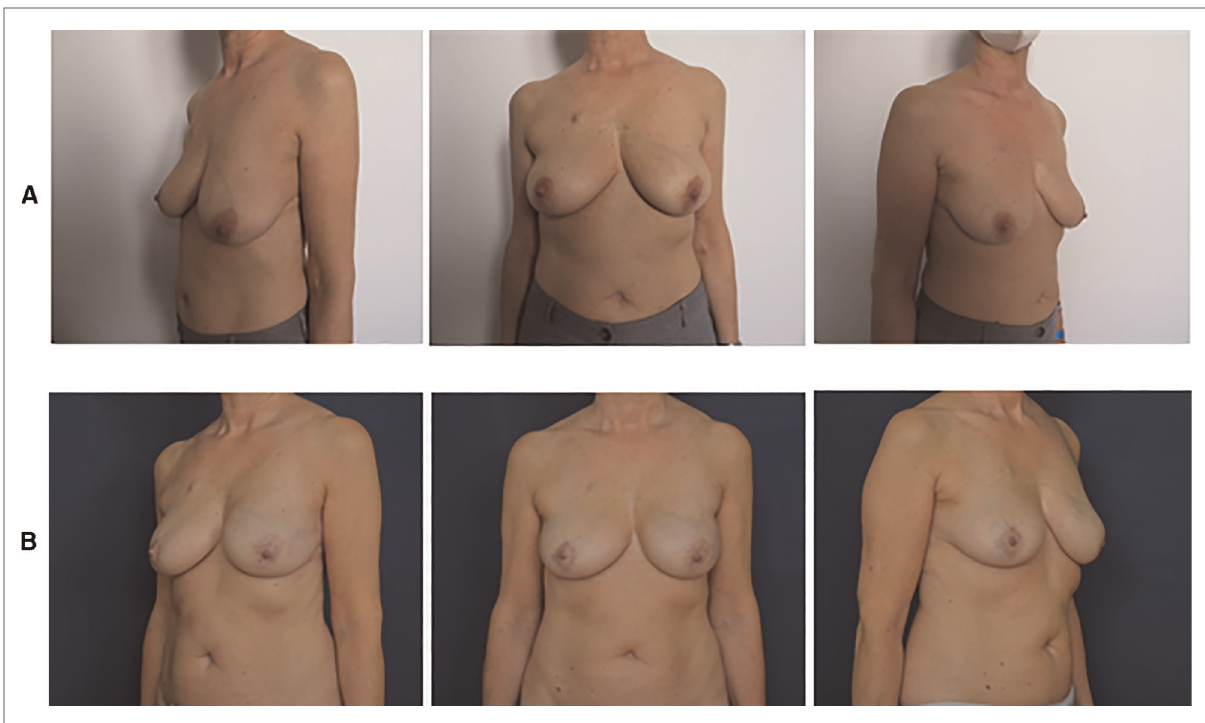
FIGURE 2 Pre- and postoperative pictures of BRAXON ® Fast -assisted PPBRs. ( A ) Patient with left breast cancer: preoperative pictures. ( B ) Patient with left breast cancer: 8 months after left prepectoral reconstruction surgery with BRAXON ® Fast and breast implant, contralateral reduction